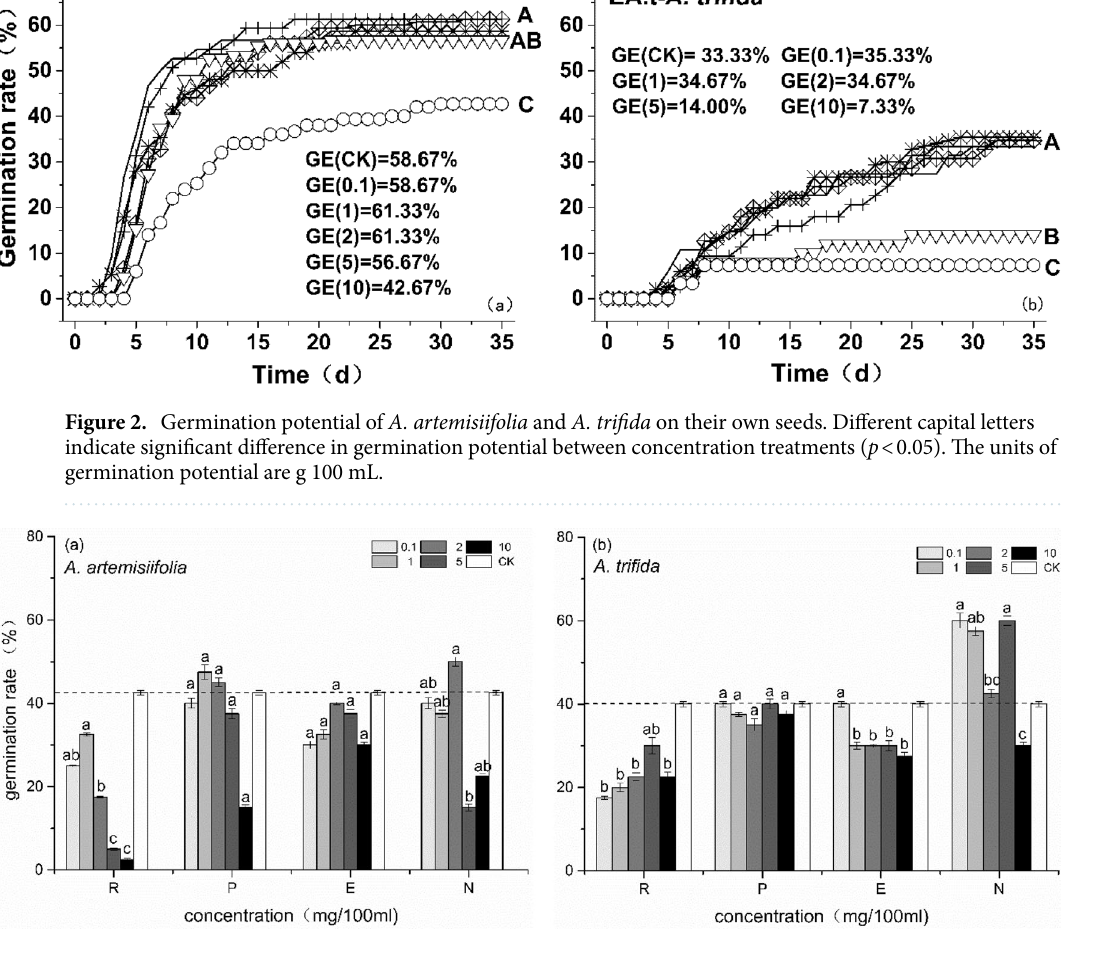
Figure 3. Effects of three organic extraction phases and residual water on seed germination rate of A. artemisiifolia ( a ) and A. trifida ( b ). In the figure, R represents the remaining water phase of the extraction, P represents the petroleum ether extraction phase, E represents the ethyl acetate extract phase and N represents the 1-butanol extract phase. Values are mean ± SE. Different lowercase letters indicate that the seed germination rate of the same species at different concentrations was significantly different ( p < 0.05). A. artemisiifolia seeds were treated with A. artemisiifolia plant extract, and A. trifida seeds were treated with A. trifida plant extract. Dashed line shows the germination rate of